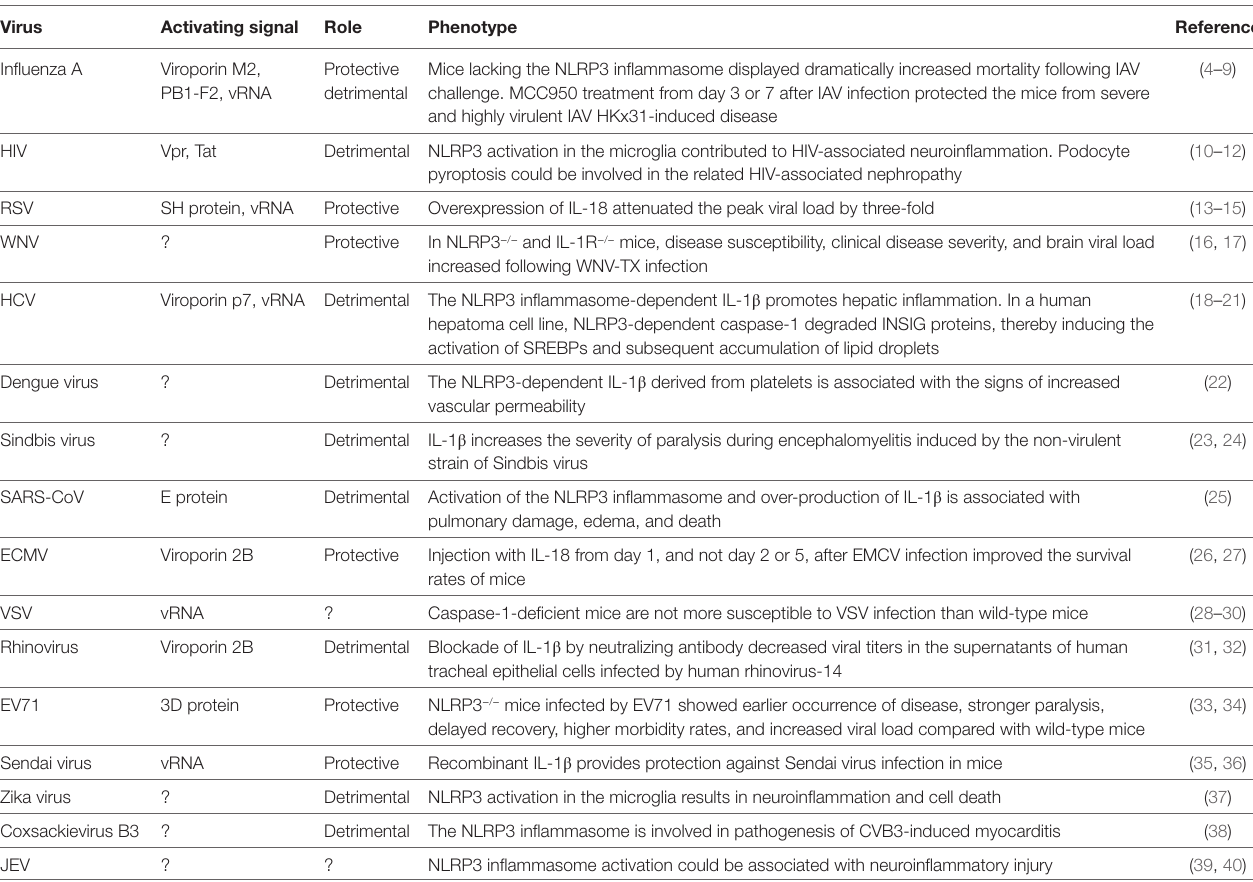
TAbLe 1 | Activating signals for and roles of the NACHT, LRR, and PYD domains-containing protein 3 (NLRP3) inflammasome in ribonucleic acid (RNA) viral